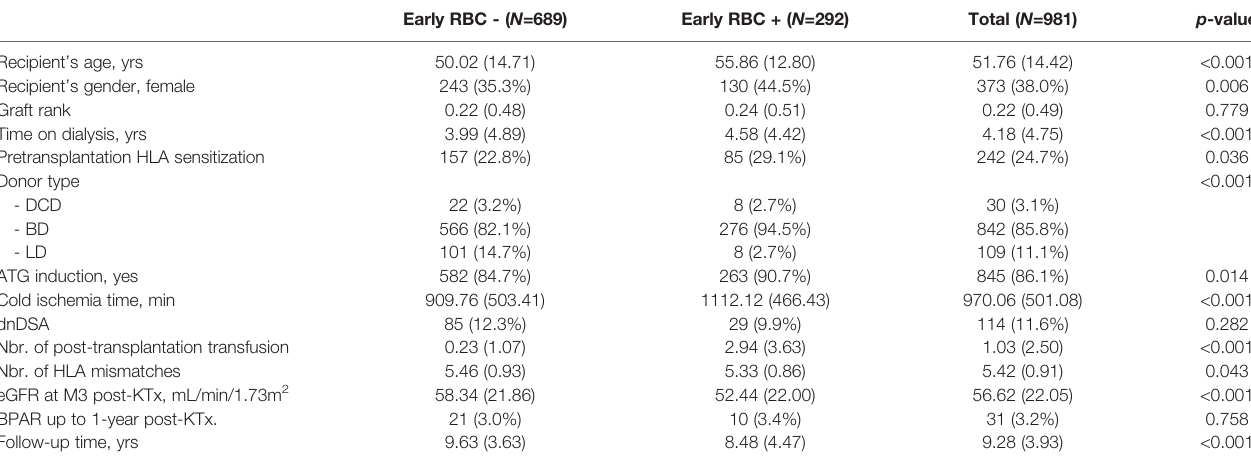
TABLE 1 | Comparative demographics and potential confounders between transfusion